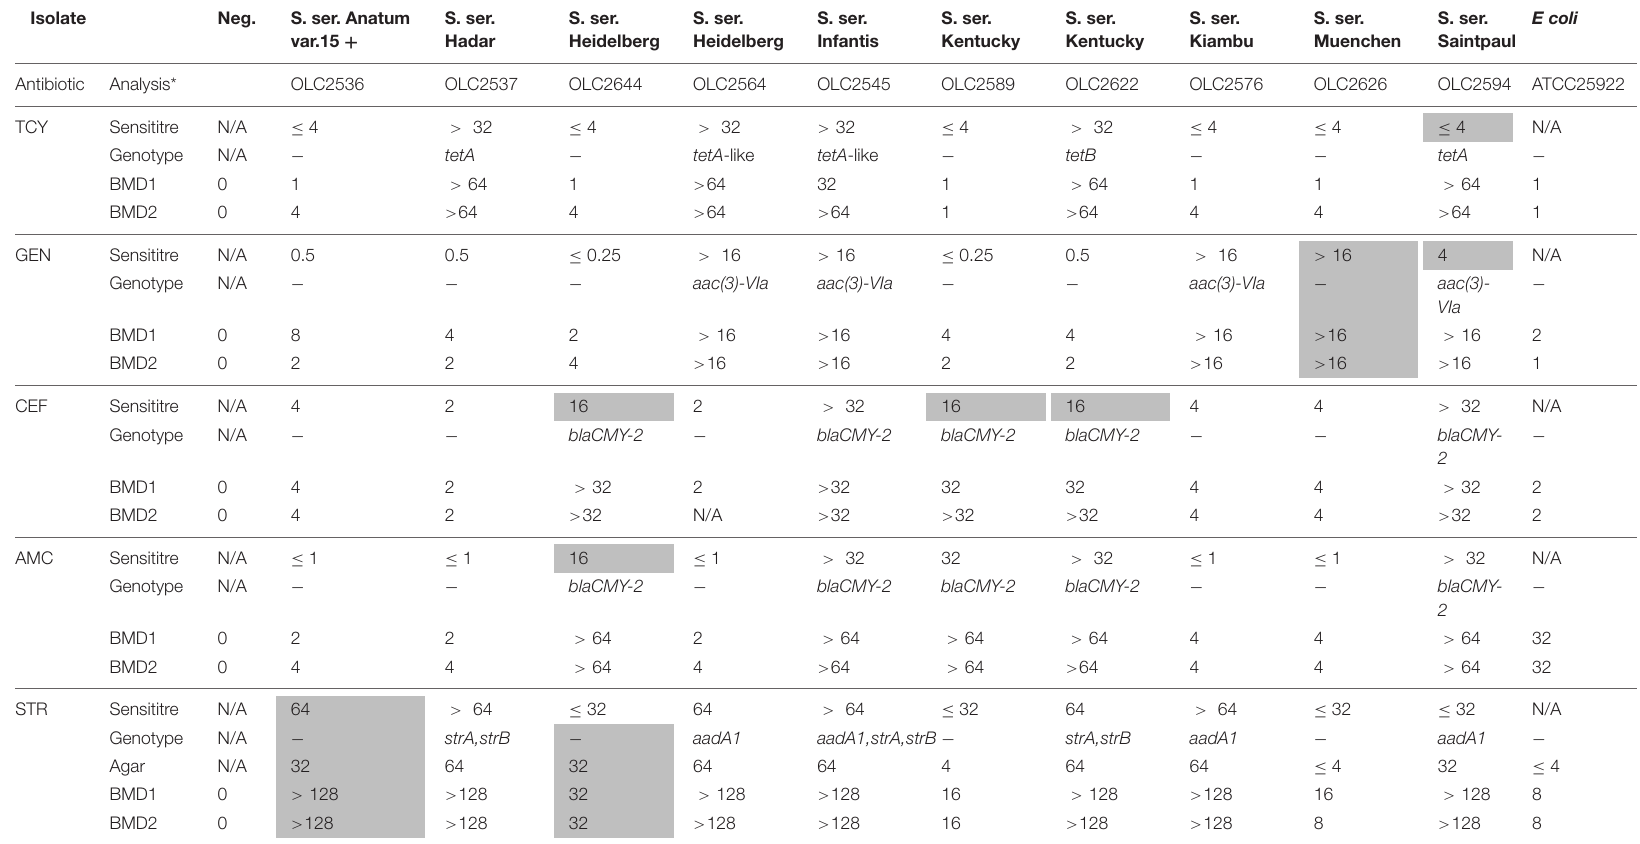
TABLE 7 | Broth microdilution testing of isolates with genotype-phenotype discrepancies. Isolate